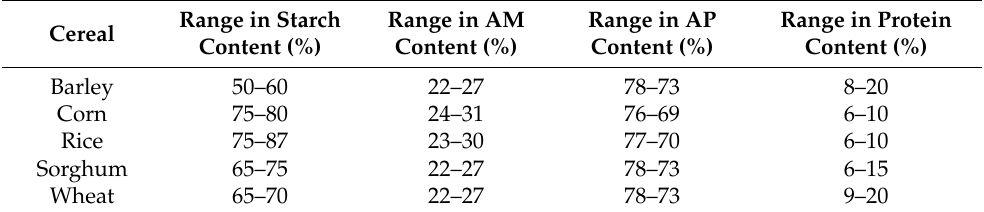
Table 2. Range of total starch, amylose (AM), amylopectin (AP) and protein content in the five predominant cereal brewing grains